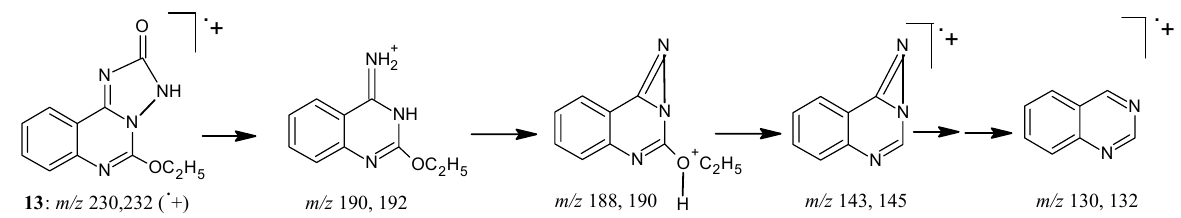
Scheme 18. Mass spectrum interpretation for compound 13 .